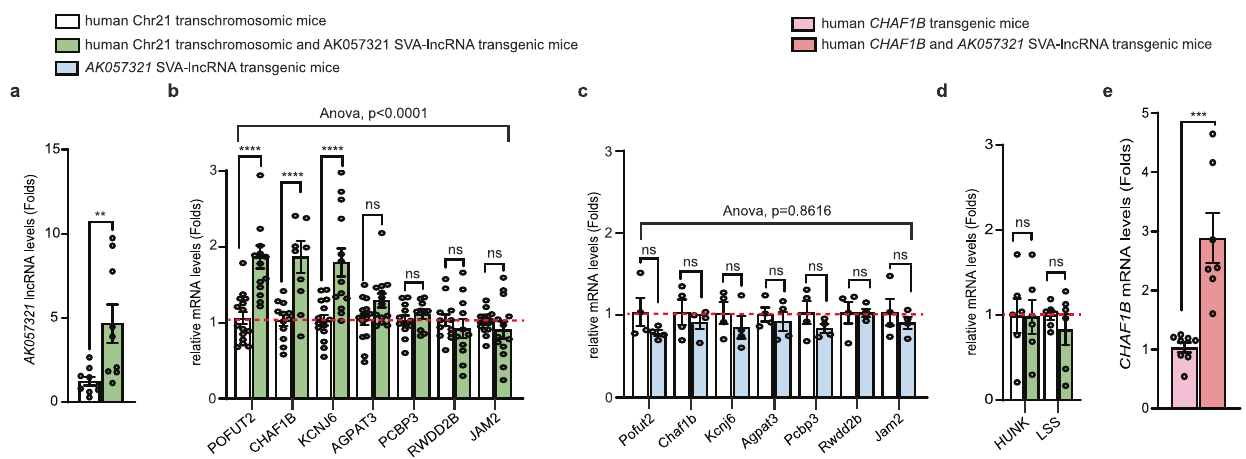
Fig. 6 SVA-lncRNA AK057321 increases expression of CHAF1B , KCNJ6 , and POFUT2 genes with intronic SVAs on human chromosome 21 but not mouse orthologs in mouse cortex. a RT-qPCR of AK057321 transcript levels shown in mouse cortex from human Chr21 transchromosomic/1x AK057321 mice compared to human Chr21 transchromosomic mice. n = 9 biological replicates. Unpaired Student ’ s t test. b RT-qPCR expression levels of human genes with intronic SVAs from mouse cortex of human Chr21 transchromosomic/1x AK057321 mice compared to human Chr21 transchromosomic mice. n = 11 – 14 biological replicates. One-way ANOVA ( F 13,165 = 10.38, p < 0.0001) with Bonferroni post hoc tests. c RT-qPCR of ortholog mouse gene expression from mouse cortex in AK057321 SVA-lncRNA transgenic mice compared to wild-type mice. n = 4 biological replicates. One-way ANOVA ( F 13,42 = 0.5728, p = 0.8616) with Bonferroni post hoc tests. d Expression levels of two human Chr21 genes without intronic SVAs shown from mouse cortex of human Chr21 transchromosomic/1x AK057321 mice compared to human Chr21 transchromosomic mice. Measured by RT-qPCR. n = 6 biological replicates. Unpaired Student ’ s t test. e Expression level of CHAF1B from mouse cortex of human CHAF1B transgenic mice compared to human CHAF1B transgenic/ AK057321 transgenic mice. Measured by RT-qPCR. n = 7 biological replicates. Unpaired Student ’ s t test. a – e B2M used as the internal reference gene. Data represent the mean ± SEM. **** p < 0.0001, *** p < 0.001, ** p < 0.01, ns p >